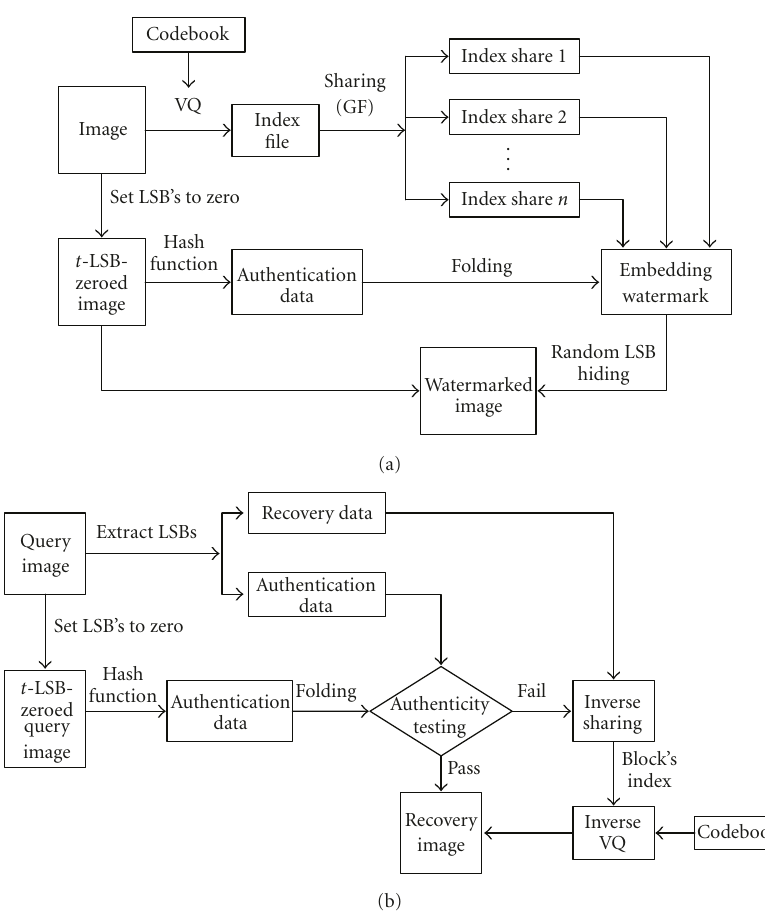
Figure 1: Two flowcharts show the proposed method: (a) the encoding (watermarking) procedure, (b) the decoding (verification and recovery)